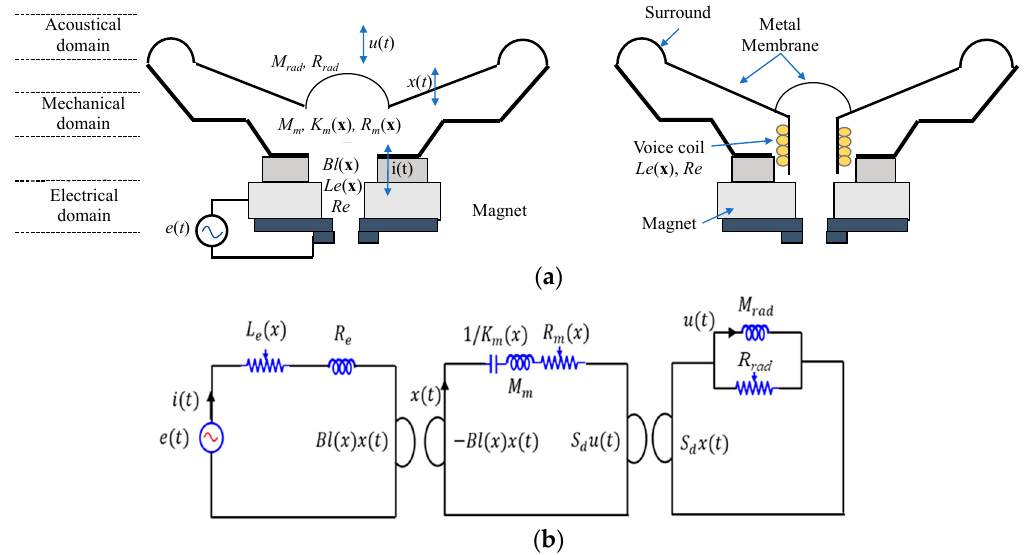
Figure 1. Schematic representations of ( a ) A miniature transducer. ( b ) Diagram showing and key parameters, and ( b ) Diagram of the equivalent circuit.